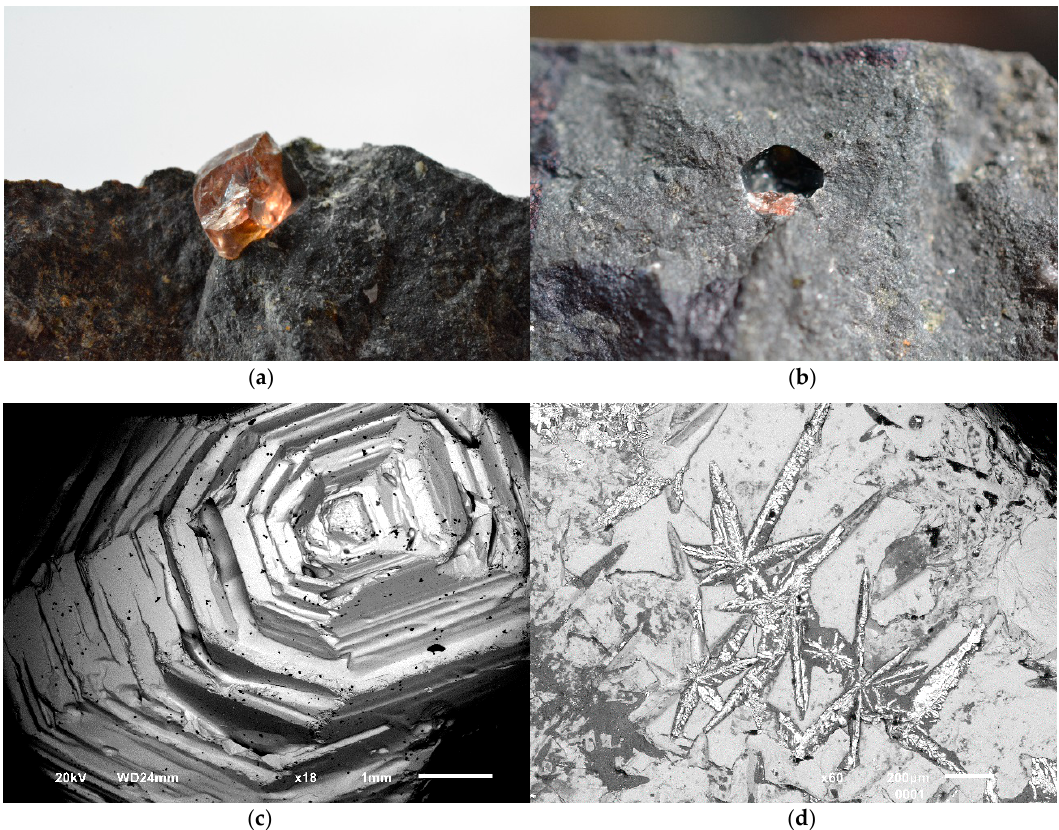
Figure 6. Zircon xenocrysts from the RVP: ( a ) euhedral zircon (7 × 4.5 × 4 mm) in situ from Phnom Dang, Bokeo. ( b ) Glassy reaction rim (1–2 µm wide lining the 5 mm hole) between zircon xenocryst and the host alkali basalt. ( c ) Hopper-type growth feature on the subhedral zircon. ( d ) Late-stage dendritic etching in-filled by baddeleyite on the surface of a zircon xenocryst.